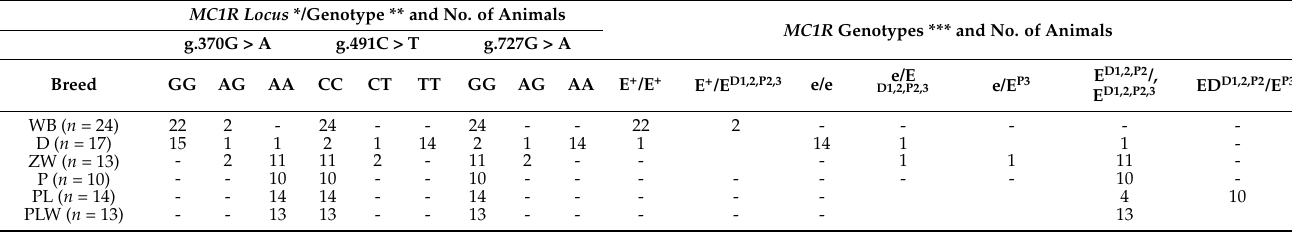
MC1R Genotypes *** and No. of Animals